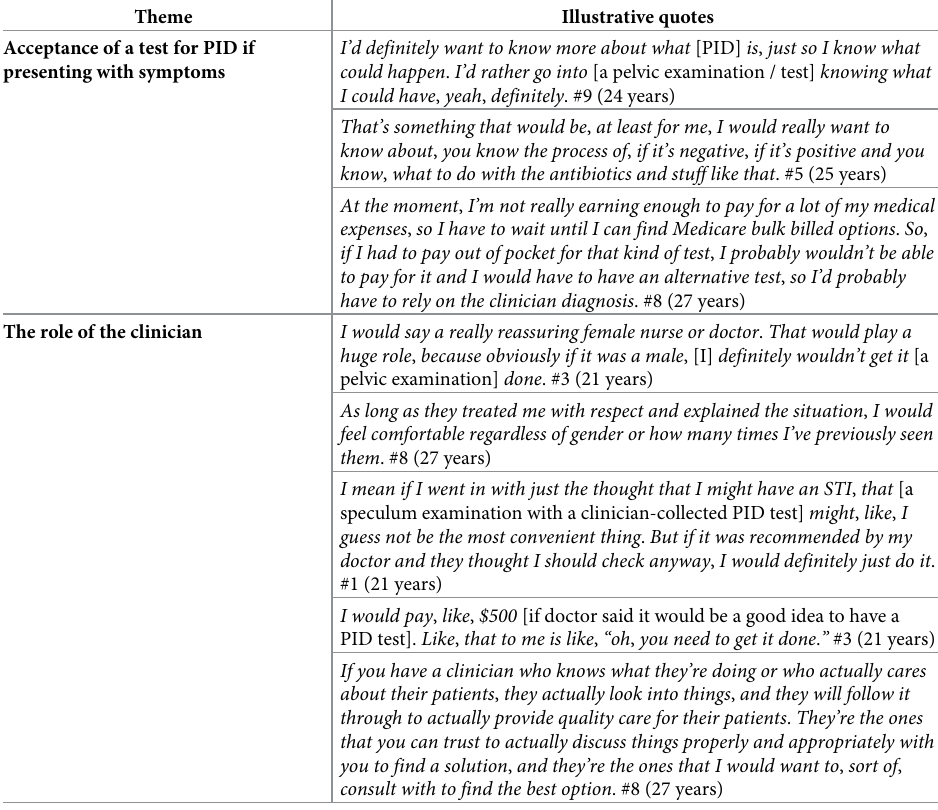
Table 3. Themes and illustrative quotes from interviews with young